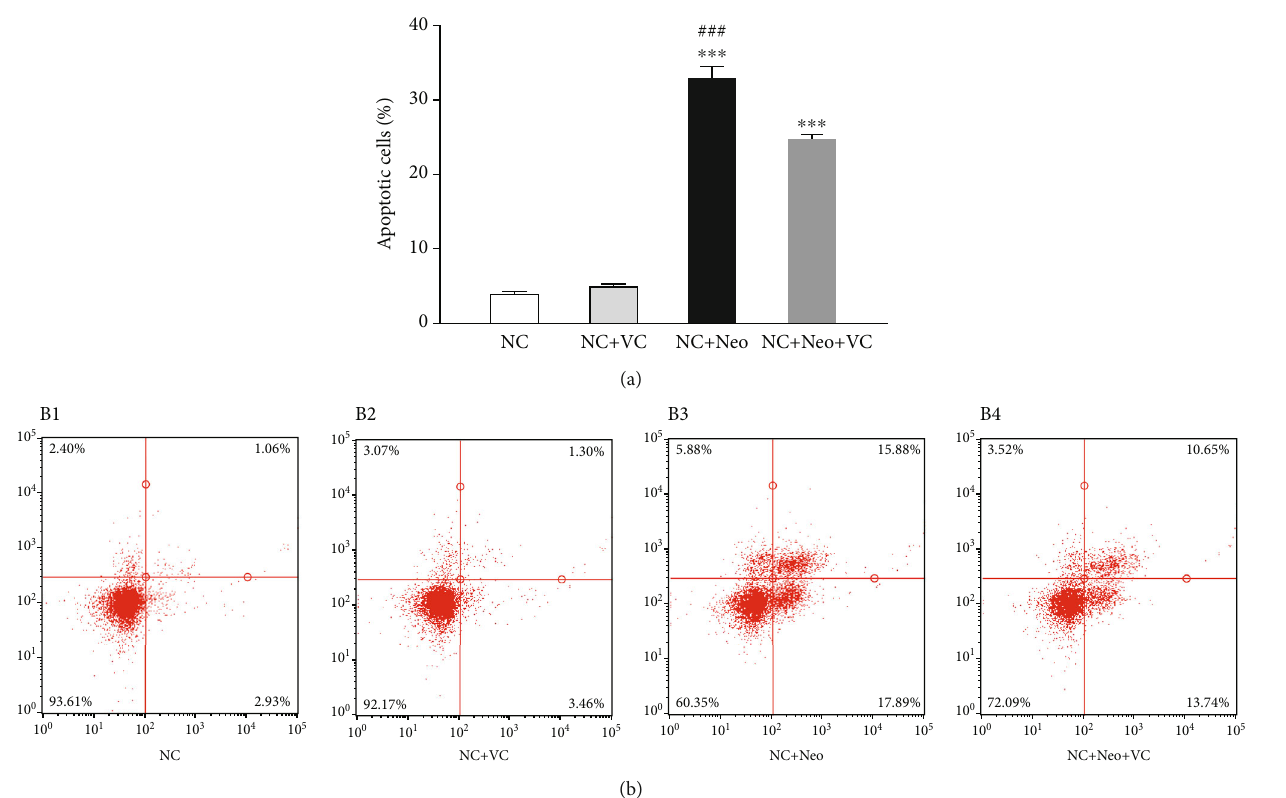
Figure 7: VC e ff ects on neomycin-induced HEI-OC1 cell apoptosis. Flow cytometry of Annexin V-FITC and PI double-stained HEI-OC1 cells were assigned as apoptosis. Total apoptosis includes early and late-stage apoptosis. Quanti fi cation of the percentage of apoptosis is shown (a). One-way ANOVA, ∗∗∗ p < 0 : 001 versus NC group and ### p < 0 : 001 versus NC+Neo+VC group. Histograms of four groups were exhibited (b1 – b4). Neomycin increased early (LR) and late apoptosis (UR), and neomycin-induced apoptosis was inhibited by cotreatment with VC. All tests were repeated four times